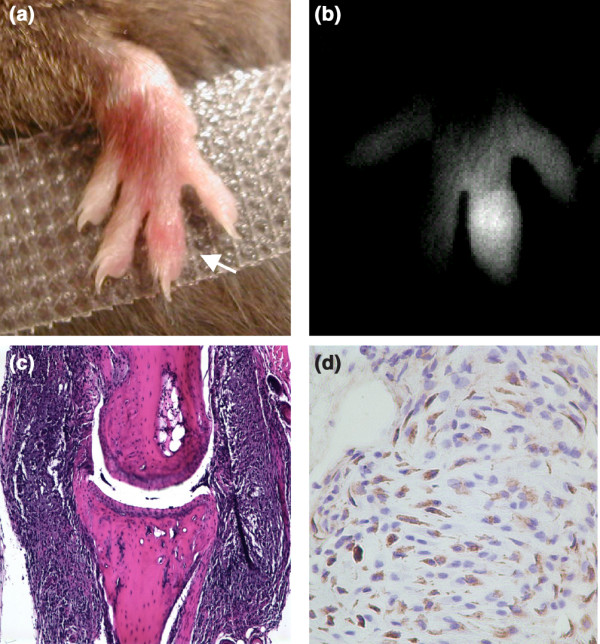
Establishment of the KRN serum transfer model. (a) Discoloration and swelling (arrow) of the right third proximal interphalangeal joint is noted in a healthy C57BL/6 mouse 4 days after KRN serum transfer. (b) Near-infrared fluorescent imaging of the right paw showed increase fluorescence signal intensity at the inflammatory joint (enhancement ratio = 1.9). (c) Correlated H&E-stain section showed abundant inflammatory cells infiltration with pannus-like formation. Original magnification, 100 ×. (d) Immunoperoxidase staining of Mac-3. Mac-3-positive cell infiltration among polymorphonuclear cells was noted in the pannus. Original magnification, 400 ×.